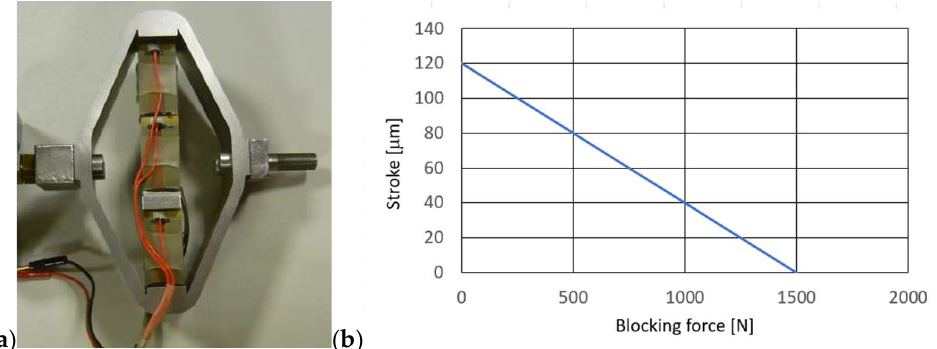
Figure 3. Piezoelectric actuator APA-120L [30], ( a ) view of the piezoelectric actuator, ( b ) characteristic of the piezoelectric actuator